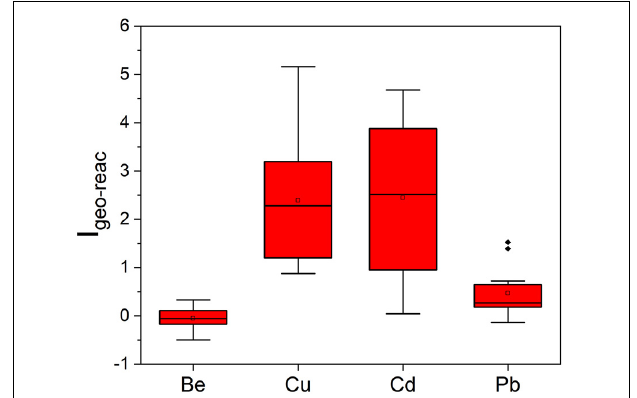
FIGURE 4 | Geo-accumulation indexes ( I geo − reac ) of Be ( 9 Be), Cu, Cd, Pb in bottom suspended sediments of the PRE.